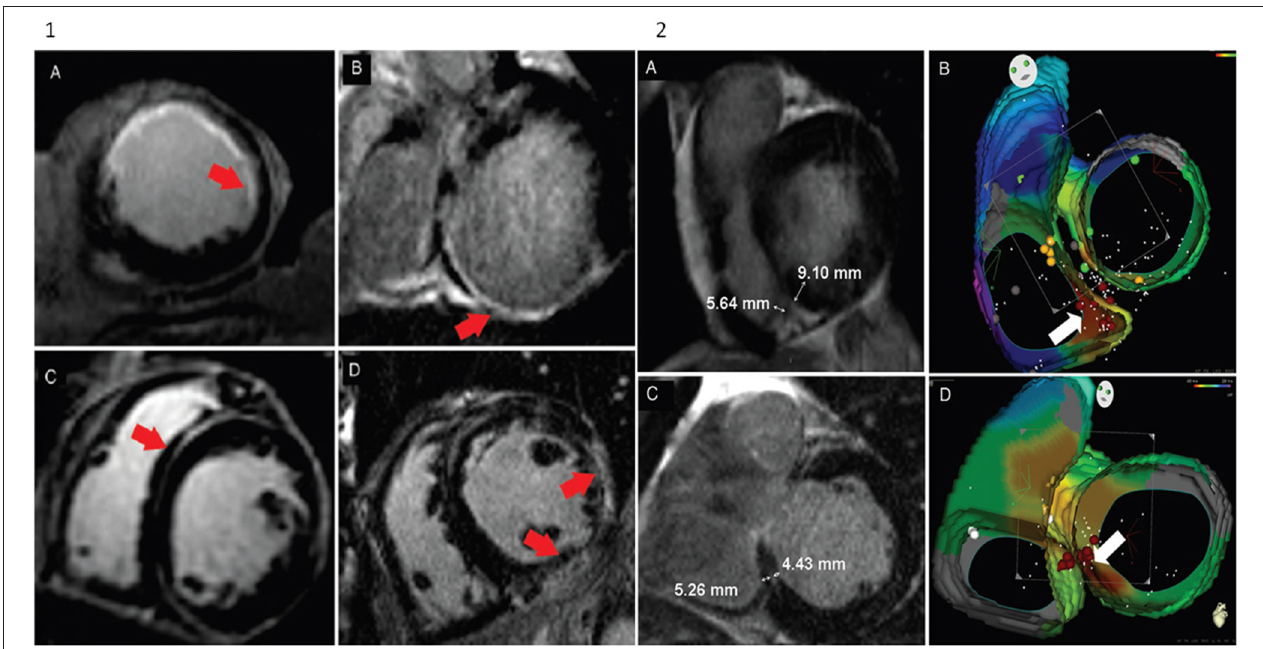
FIGURE 2 | Adapted from Andreu et al. (29). Panel 1: Pattern distribution of hyperenhancement in cardiac magnetic resonance images. (A) Endocardial hyperenhancement in left ventricle the anterior wall. (B) Transmural hyperenhancement in the left ventricle posterior wall and endocardial hyperenhancement of the posteroseptal wall. (C) Mid-myocardial hyperenhancement in the anteroseptal wall. (D) Epicardial hyperenhancement in the left ventricle lateral wall. Panel 2: Cardiac magnetic resonance and electroanatomical map of two patients with mid-myocardial hyperenhancement at the successful ablation site. (A,B) Endocardial ablation of premature ventricular contractions originating from the right ventricle. (A) The distance to the boundary of the hyperenhancement region was shorter in the right ventricle than in the left ventricle. (B) Radiofrequency ablation of the right ventricle was performed. (C,D) Endocardial ablation of the left ventricle. (C) In this case, the distance to the boundary of the hyperenhancement region was shorter from the left ventricle than from the right ventricle. (D) A previous unsuccessful radiofrequency ablation was attempted in the right ventricle. After mapping, the left ventricle the maximum precocity of the left ventricle septum was obtained, and radiofrequency ablation eliminated premature ventricular